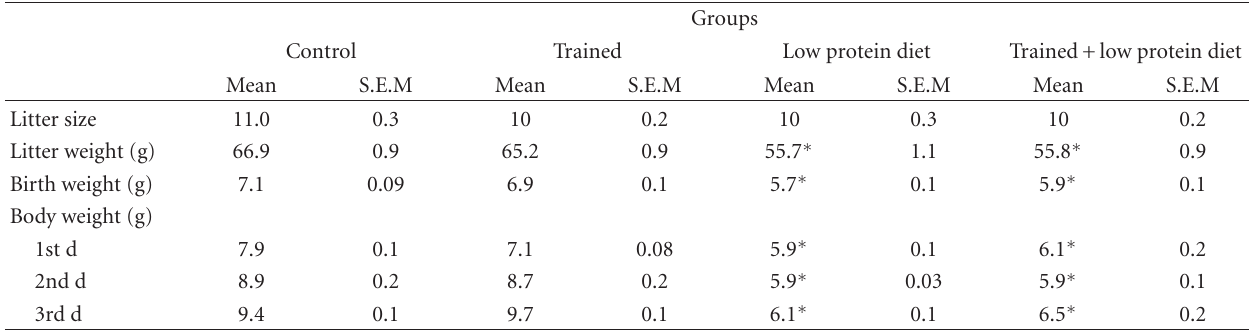
Table 2: Indicators of litter size, litter weight, and body weight at birth to 3rd d of life.